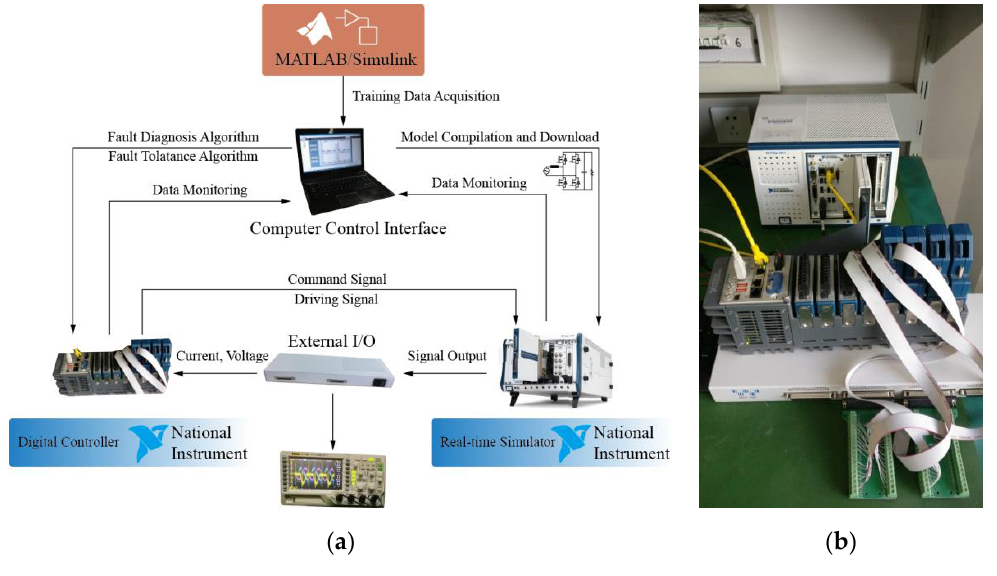
Figure 11. Diagram of simulation and experiment setup.